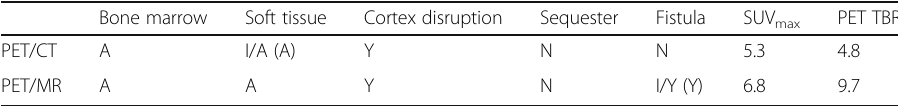
Table 2 Consensus results for patient